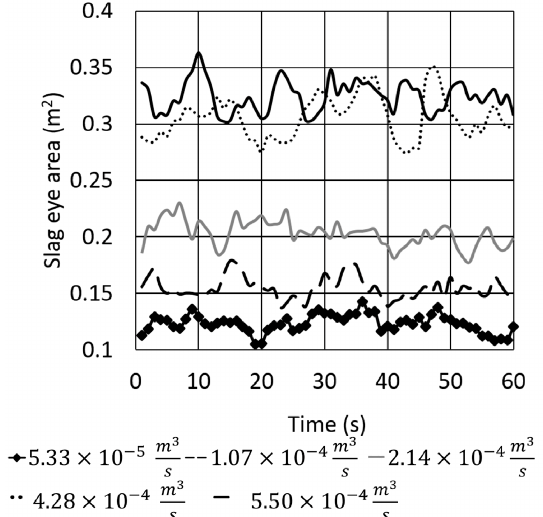
Figure 4. Effects of gas flow rate for an upper layer thickness of 0.02 m on the variations of the eye opening area with time.